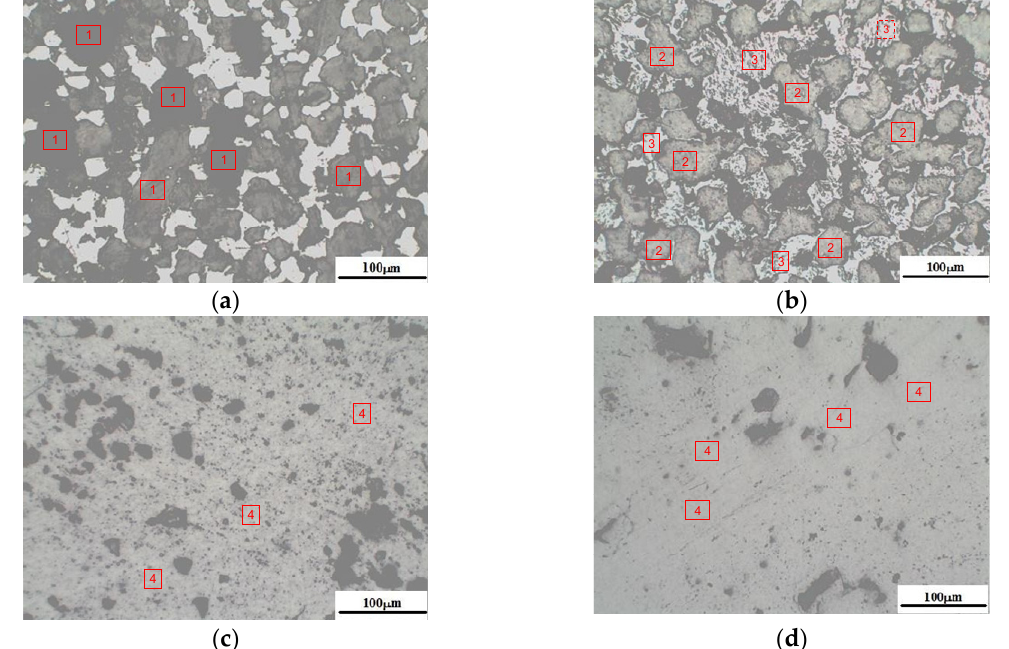
Figure 4. Morphologies of oversize substances of steel slag powder vs. grinding time: ( a ) 0 min; ( b ) 20 min; ( c ) 50 min; ( d ) 70 min.